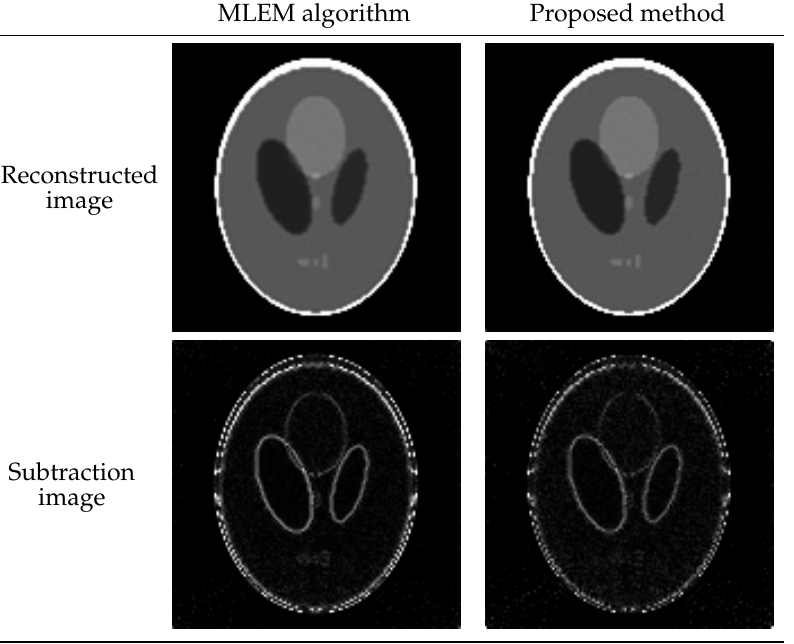
Figure 16. Images reconstructed from projection y 8 by using the proposed method with parameter ˆ λ 3 and the MLEM algorithm. Subtraction images display in the range from 0 to